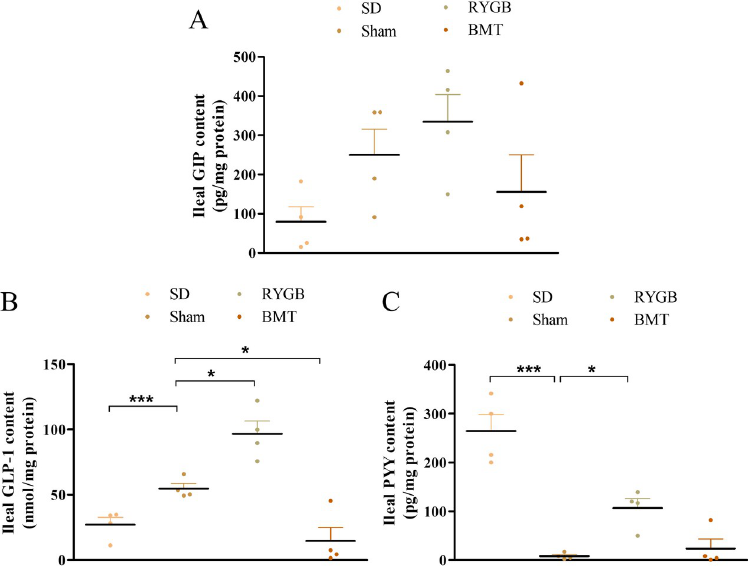
Fig 6. Effects of RYGB, BMT and sham surgery on ileal hormone content in ZDSD rats. (A) Ileal PYY content (pg/ mg protein), (B) ileal GLP-1 content (nmol/mg protein) and (C) ileal GIP content (pg/mg protein). Normal SD rats are included for comparison. Values are mean ± SEM (n = 4) with statistical significance evaluated using one-way ANOVA. � p < 0.05, ��� p < 0.001 compared to sham.